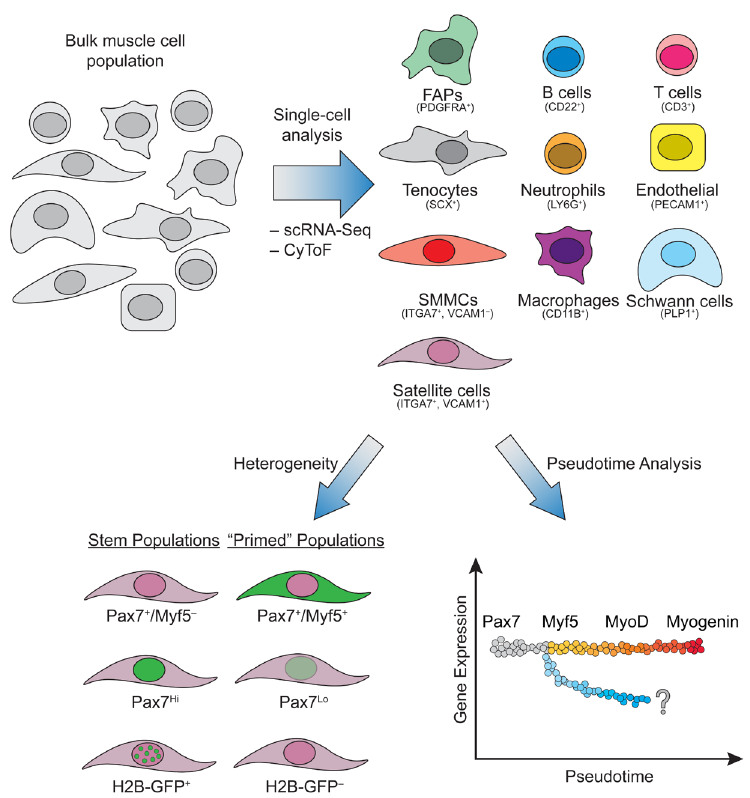
Figure 1. Single-cell analysis allows the identification of cell types residing in skeletal muscle. Top: Tools such as single-cell RNA sequencing (scRNA-Seq) and cytometry time of flight (CyToF) have been used to determine the identity of numerous cell types residing in skeletal muscle based on their transcriptional and protein signature. Notably, in addition to muscle fibers, muscle comprises satellite cells, immune cells, fibroblasts, endothelial cells, and Schwann cells. Bottom: The heterogeneity within the satellite cell population can be analyzed based on known markers associated with the stem cell state (Pax7 + /Myf5 – , Pax7 Hi , and H2B-GFP + label-retaining cells). Furthermore, different cell states for satellite cells can be inferred using pseudotime analysis of existing transcriptional and proteomic datasets. Cells along the gray-to-red gradient represent the known cascade of transcription factor expression following the differentiation of satellite cells into myocytes. The diverging blue gradient illustrates potential unknown cell fates. FAP, fibro-adipogenic progenitor; SMMC, smooth muscle and mesenchymal